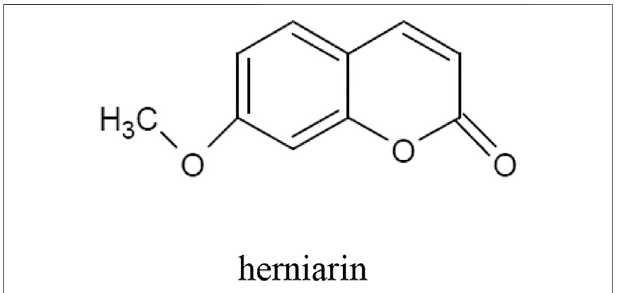
FIGURE2| Chemicalstructureofherniarin – compoundcharacteristicfor the A. dracunculus herb.